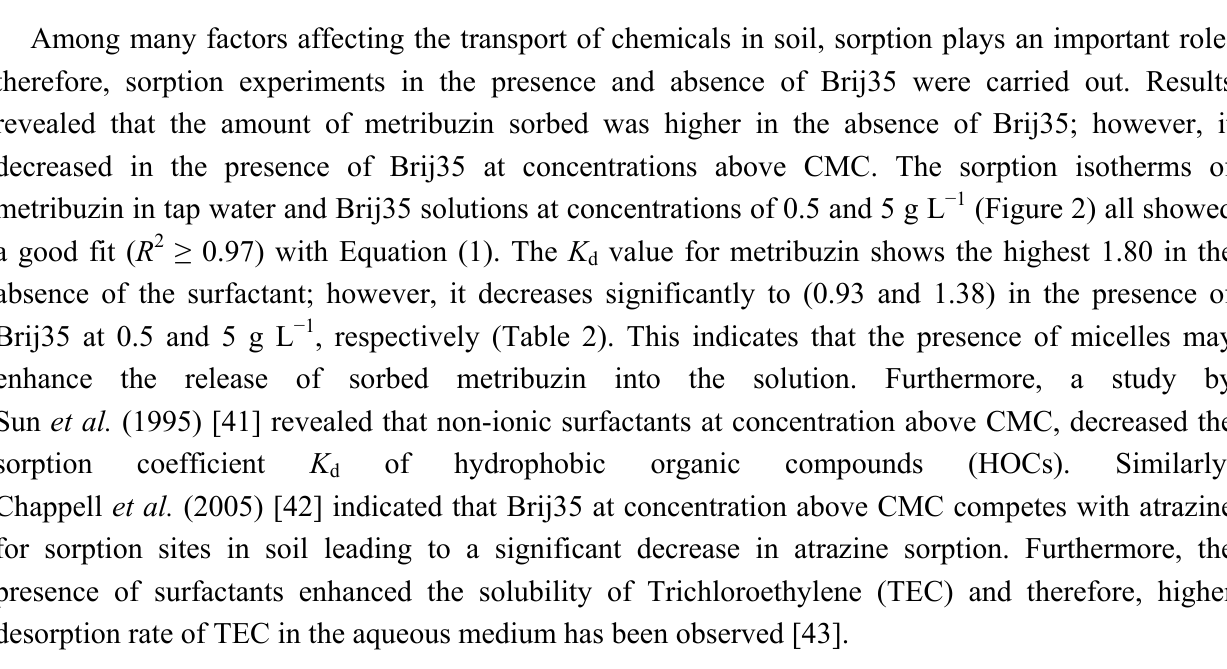
Figure 2. Metribuzin isotherms in the absence and presence of the non-ionic surfactant Brij35.